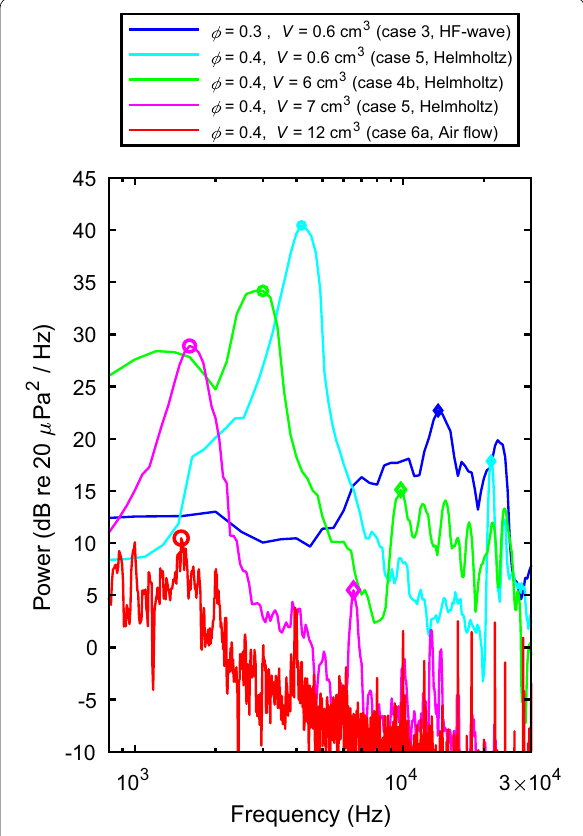
Fig. 10 Power spectra of the waveforms (highpass filtered at > 800 Hz) shown in Figs.5, 6, 7, 8, 9. Primary peak frequencies of the HF wave ( ♦ ), Helmholtz resonance ( (cid:31) ), and secondary peaks of HF wave component excited together with Helmholtz resonance ( ♦ ) are indicated. Marker sizes indicate V . For the φ = 0.4, V = 12 cm 3 case, data were not detrended and bandstop filters were applied at multiples of 2000 Hz to reduce camera noise. For other cases, data were detrended